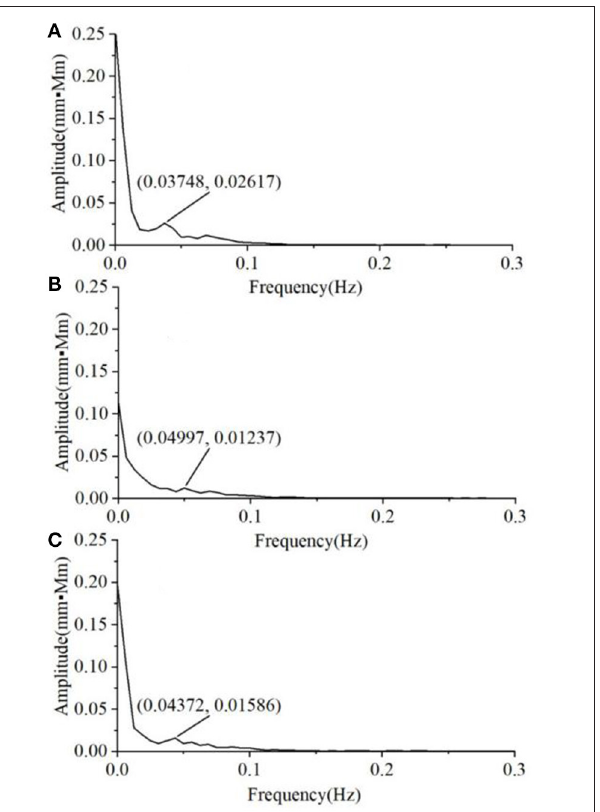
FIGURE 4 | The average magnitude spectrum of the Oxy time-course curves during the VFT task in the three groups, i.e. (A) HC, (B) MD, and (C) A&D. Note that the magnitude is almost zero at the range of 0.3–16.0Hz and not shown in the